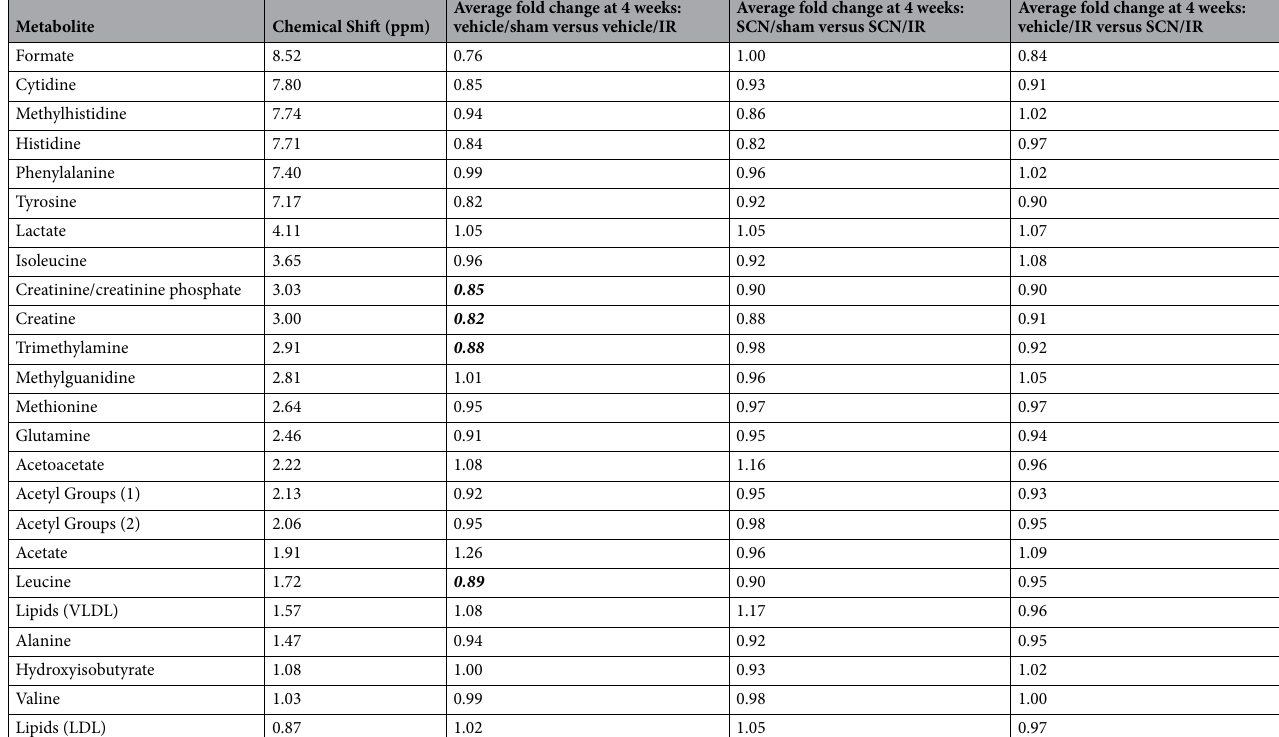
Table 2. Concentrations of major endogenous metabolites quantified in rat serum by 1 H-NMR, and their change in expression in vehicle/IR and SCN − -supplemented/IR rats at 4 weeks following surgery. Significant differences between groups were determined by two-tailed t-tests with Welch’s correction, and are indicated in bold and italicized.